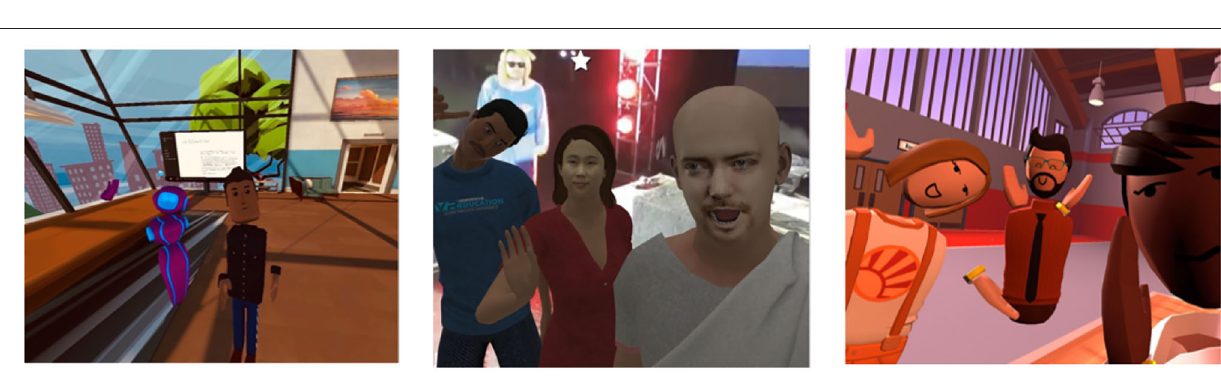
FIGURE 2 | From left: Avatars from AltspaceVR, Engage and